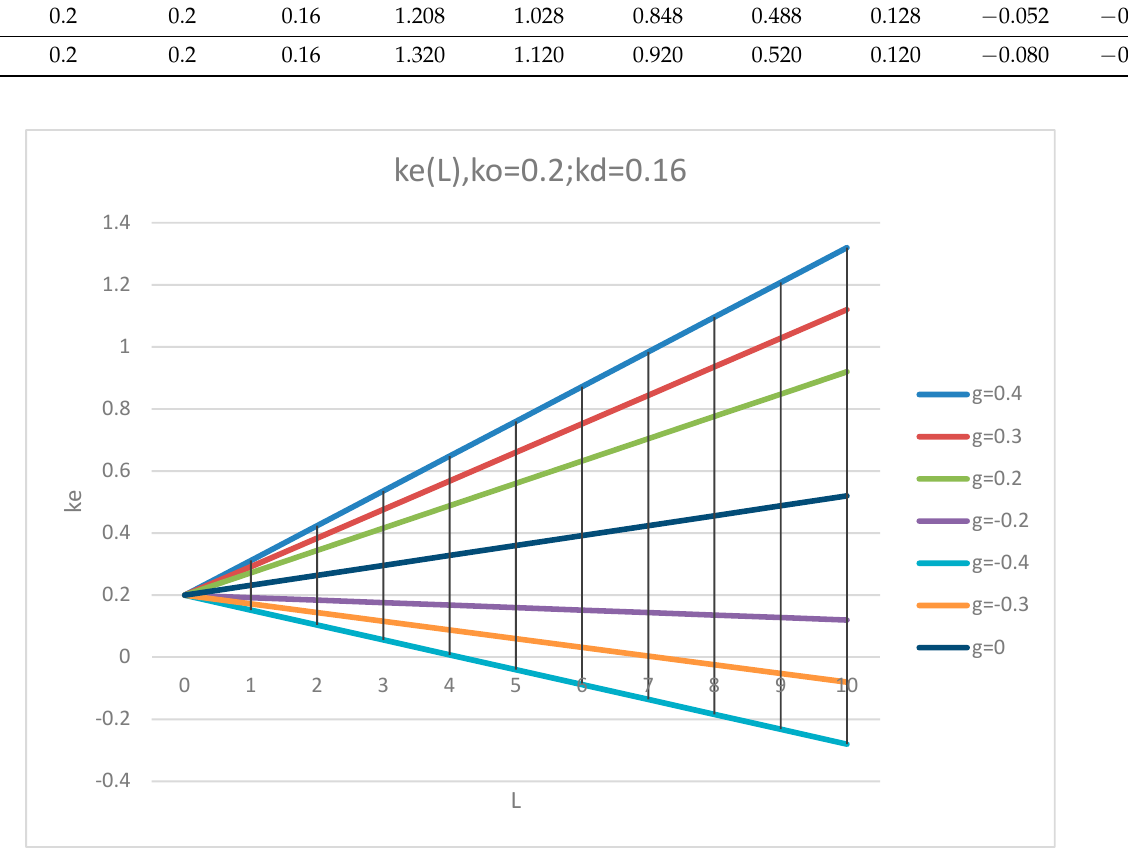
Figure 8. Dependence of equity cost k e on leverage level L in Generalized Modigliani–Miller theory (GMM theory) at k 0 = 0.2; k d = 0.16 and g = 0; ± 0.2; ± 0.3; ± 0.4.